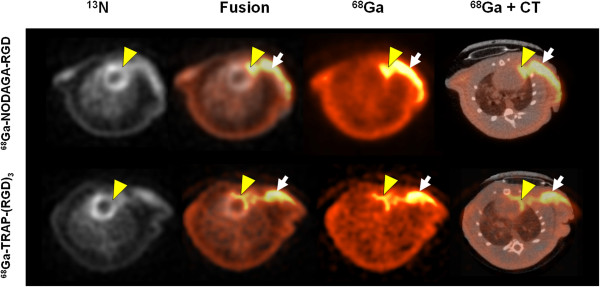
In vivo PET/CT images of rat MI. Representative transaxial sections show hypoperfused myocardium area (13N) and corresponding RGD uptake (68Ga, % ID/g). The focal uptake is seen in infarct (yellow arrowheads) and the operation scar (white arrows), as verified by CT scan.